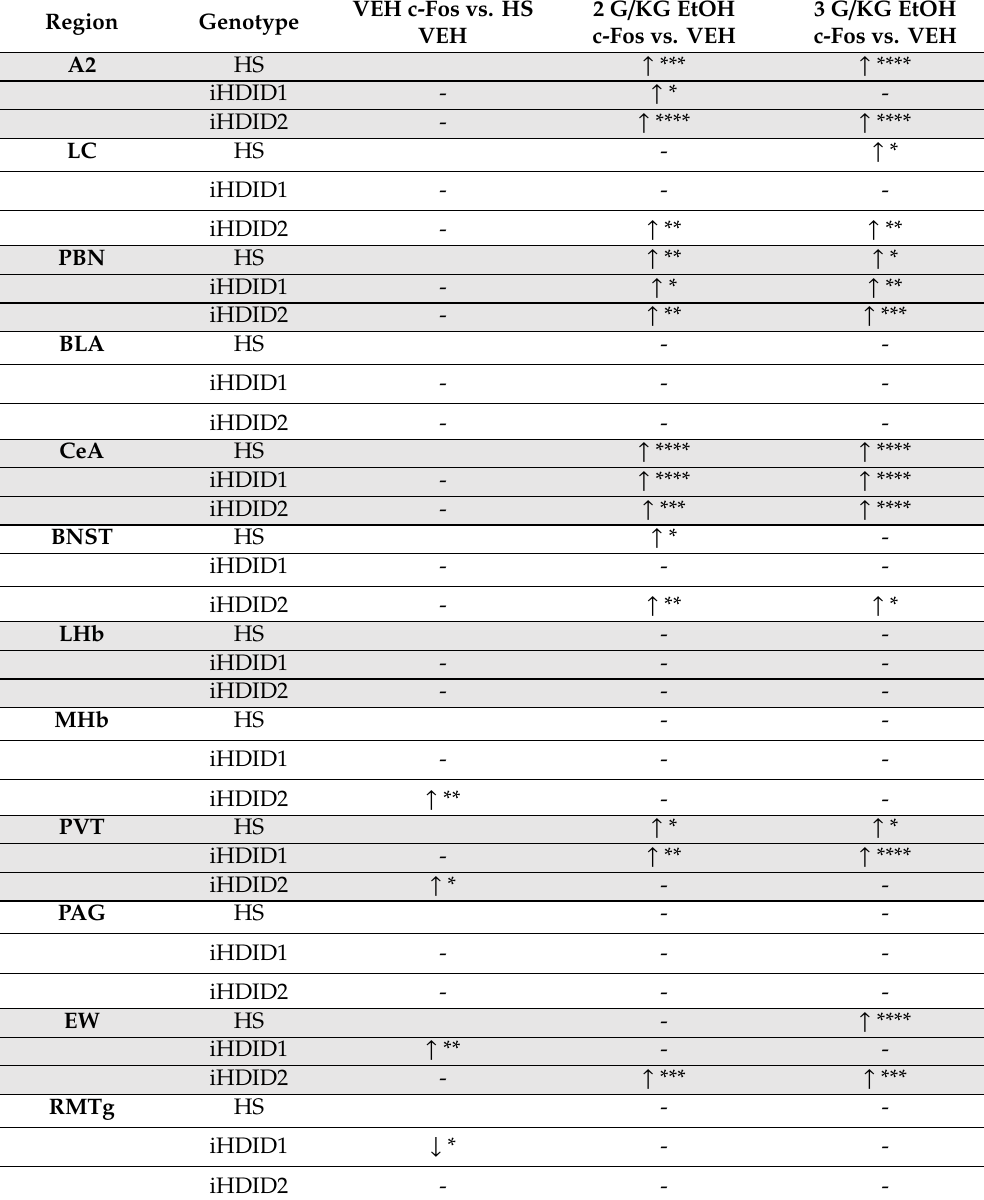
Table 1. Summary of significant di ff erences in vehicle- or ethanol-induced c-Fos expression between genotypes. Arrow indicates increase ( ↑ ) or decrease ( ↓ ) in c-Fos expression. A2: A2 region of the nucleus of tract solitary (NTS); LC: locus coeruleus; PBN: parabrachial nucleus; BLA: basolateral amygdala; CeA: central amygdala; BNST: bed nucleus of the stria terminals; LHb: lateral habenula; MHb: medial habenula; PVT: paraventricular nucleus of the thalamus; PAG: periaqueductal gray; EW: Edinger–Westphal nuclei; RMTg: rostromedial tegmental nucleus * p < 0.05, ** p < 0.01, *** p < 0.001, and **** p < 0.0001 (see results for statistical analysis